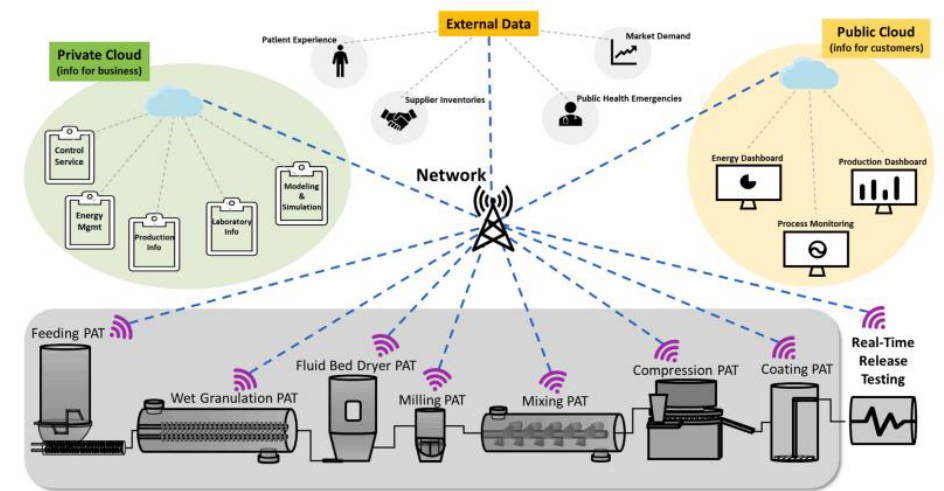
Figure 11. SCP for pharmaceutical manufacturing in I4.0.